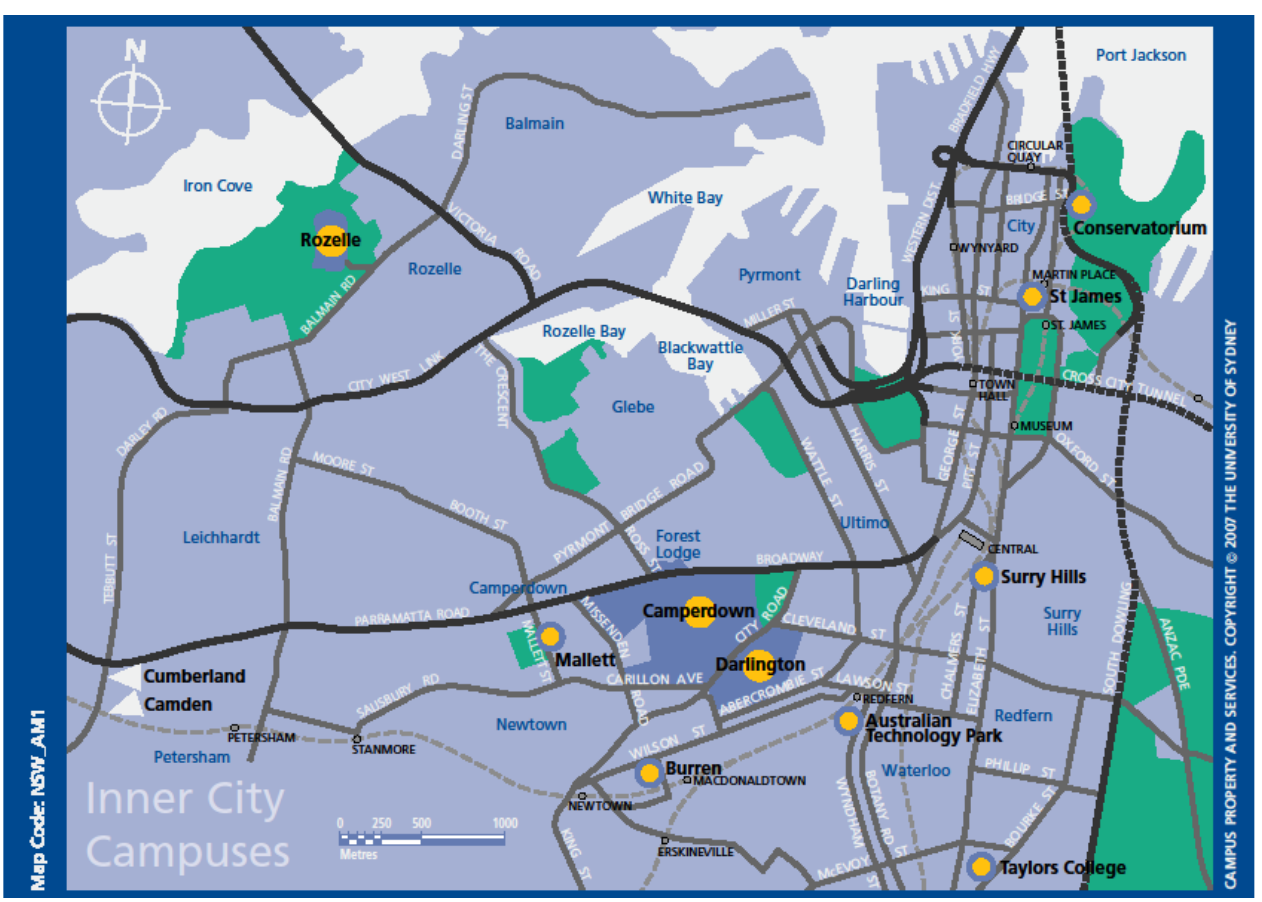
Figure 1. Inner city campuses of the University of Sydney